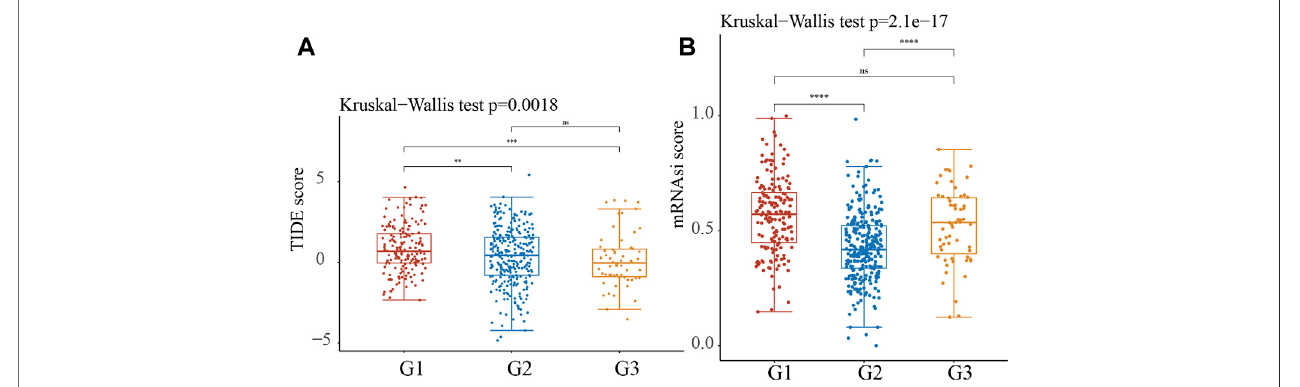
Frontiers in Cell and Developmental Biology |